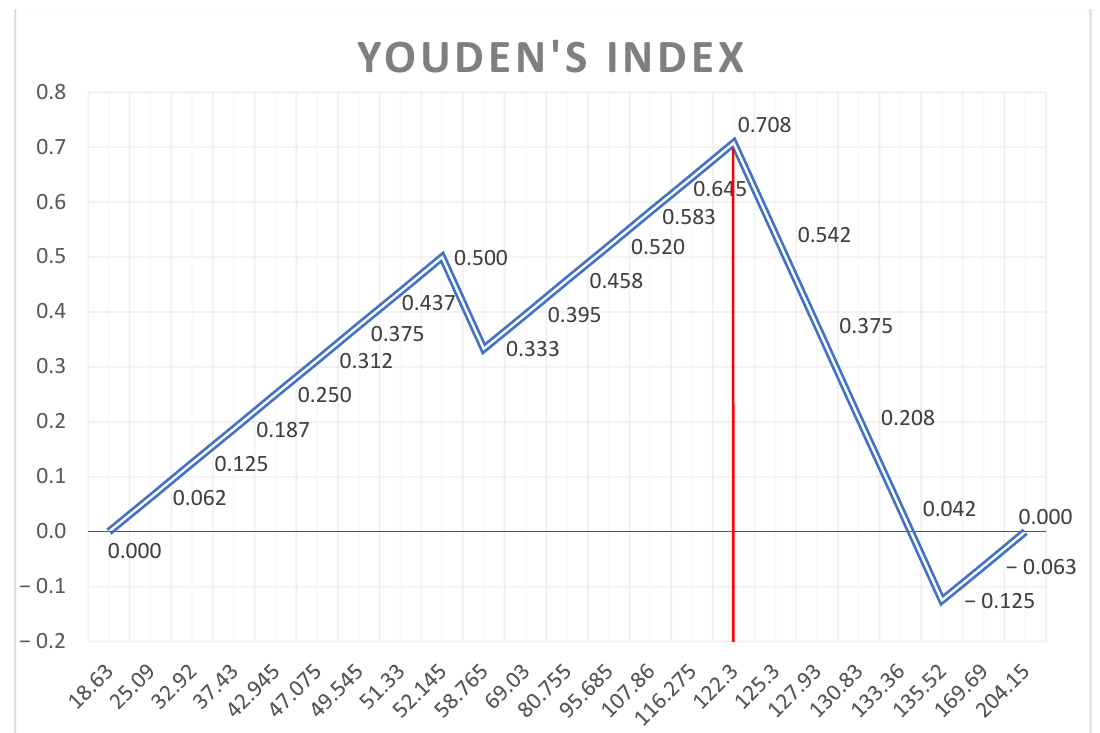
Figure 4. Youden’s Index of the ROC curve of the Basal and Mid-Ventricular segments mechani- cal dispersion.